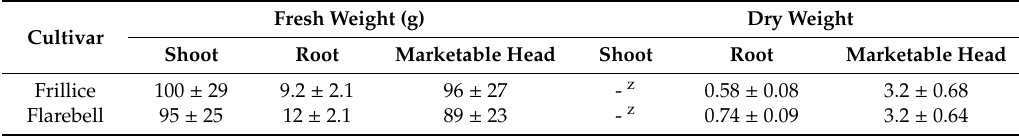
Figure 3. Monthly consumption rates of: ( a ) Electricity; ( b ) labor (work hours); ( c ) water; ( d ) CO 2 per fresh weight of the marketable head as a ff ected by monthly production rate of lettuce. Regression lines (solid line) are shown with a 95% interval level (dotted lines). Numerical data are presented in Table S2. Table 1. Fresh and dry weights of lettuce (cvs. Frillice and Flarebell) produced in the commercial closed plant production system during the research period. Average values are shown with a standard deviation of n = 104 (Frillice) and n = 116 (Flarebell).